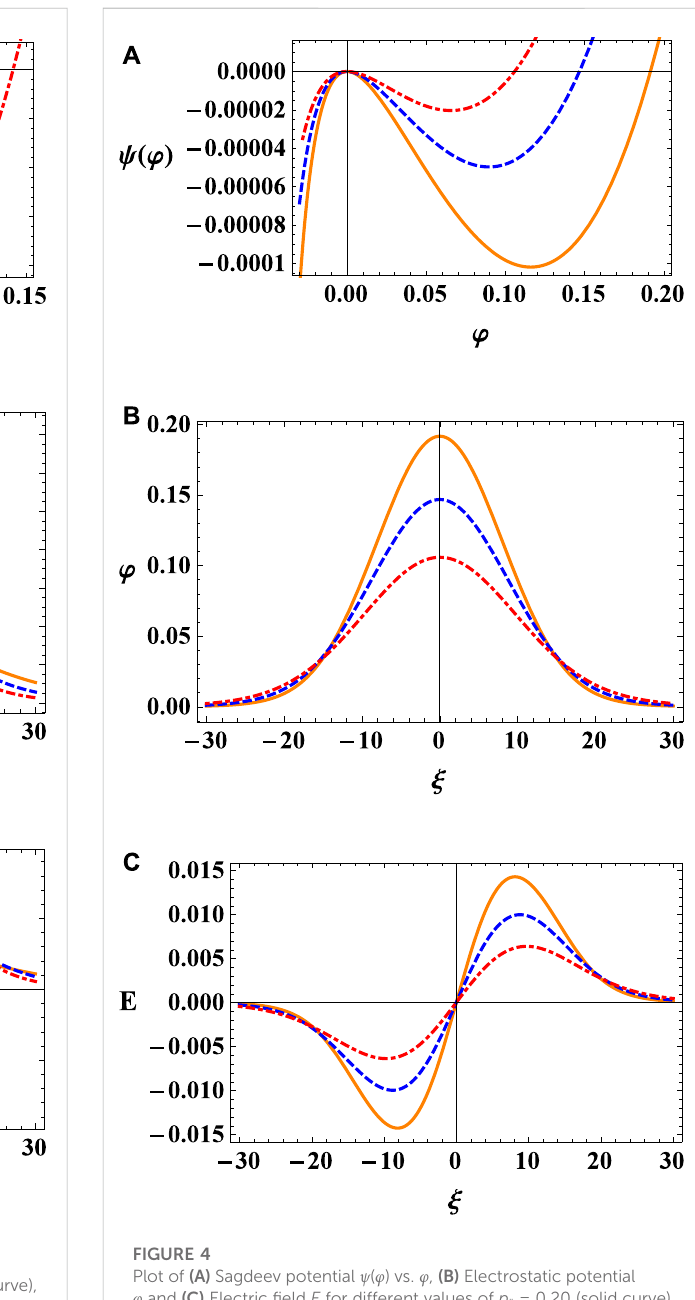
FIGURE 3 Plot of (A) Sagdeev potential ψ ( φ ) vs. φ , (B) Electrostatic potential φ and (C) Electric fi eld E for different values of γ = 0.00 (solid curve), 0.05(dashedcurve)and0.10(dot-dashedcurve)with M =0.9, Ω =0.3, p (cid:3) = 0.2, p ⊥ = 0.1, α = 0.80, and σ = 0.1.